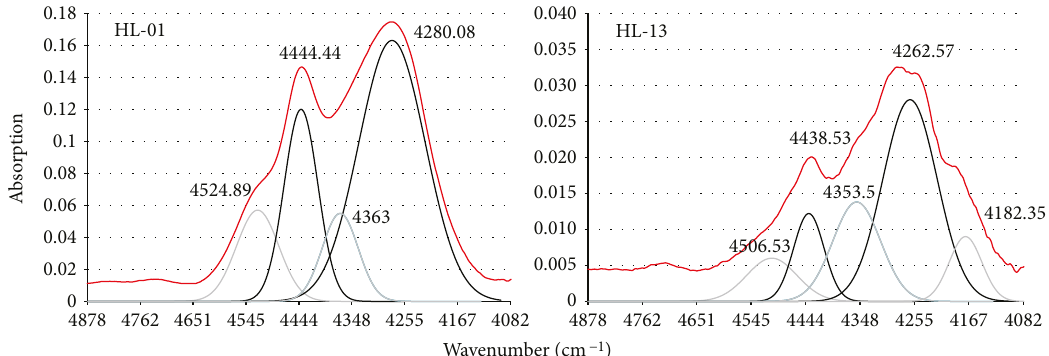
Figure 6: Decomposition of the NIR combination band of chlorites (HL-01 and HL-13). Red line: experimental; black line: fi t and diagnostic bands; and gray line: fi t and not diagnostic bands.